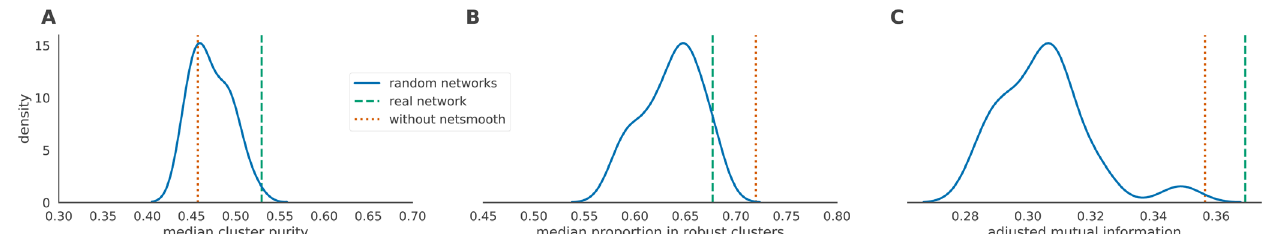
Figure 8. Performance of netSmooth with randomized networks. A ) The median cluster purity achieved with the random networks. The real network outperforms the random ones, which result in cluster purities distributed around the purity given without using netSmooth . B ) The proportion of samples assigned to robust clusters using the random networks as well as the real one. While all networks result in fewer samples robustly clustered (in the hematopoiesis dataset), the real network outperforms most random networks. C ) The Adjusted Mutual Information achieved with the randomized networks. Most random networks produce clusterings with a worse AMI than using no network-smoothing. netSmooth with the real network structure produces the clustering result with the best AMI. The online version of this figure is